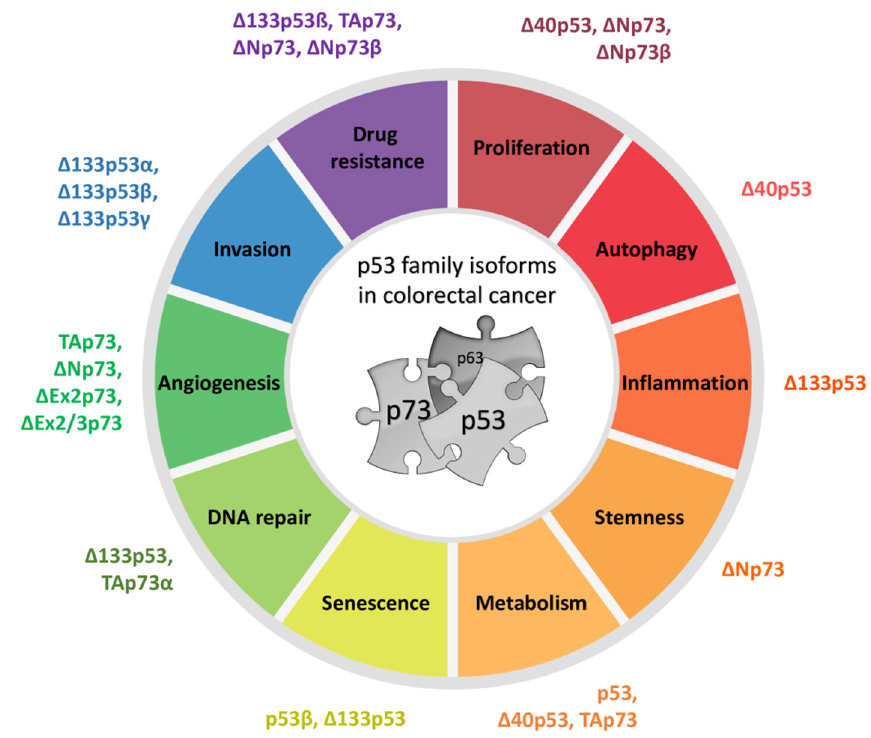
Figure 6. Biological functions of the p53/p73 family isoforms in colorectal cancer. The p53 and p73 isoforms have been implicated in many biological roles in colorectal cancer, namely, drug resistance, proliferation, autophagy, inflammation, stemness, metabolism, DNA repair, angiogenesis, and invasion. Here, the functions are organized in a circular fashion with isoforms associated with a certain biological role listed next to the roles. See Table 1 for details on molecular pathways and references.